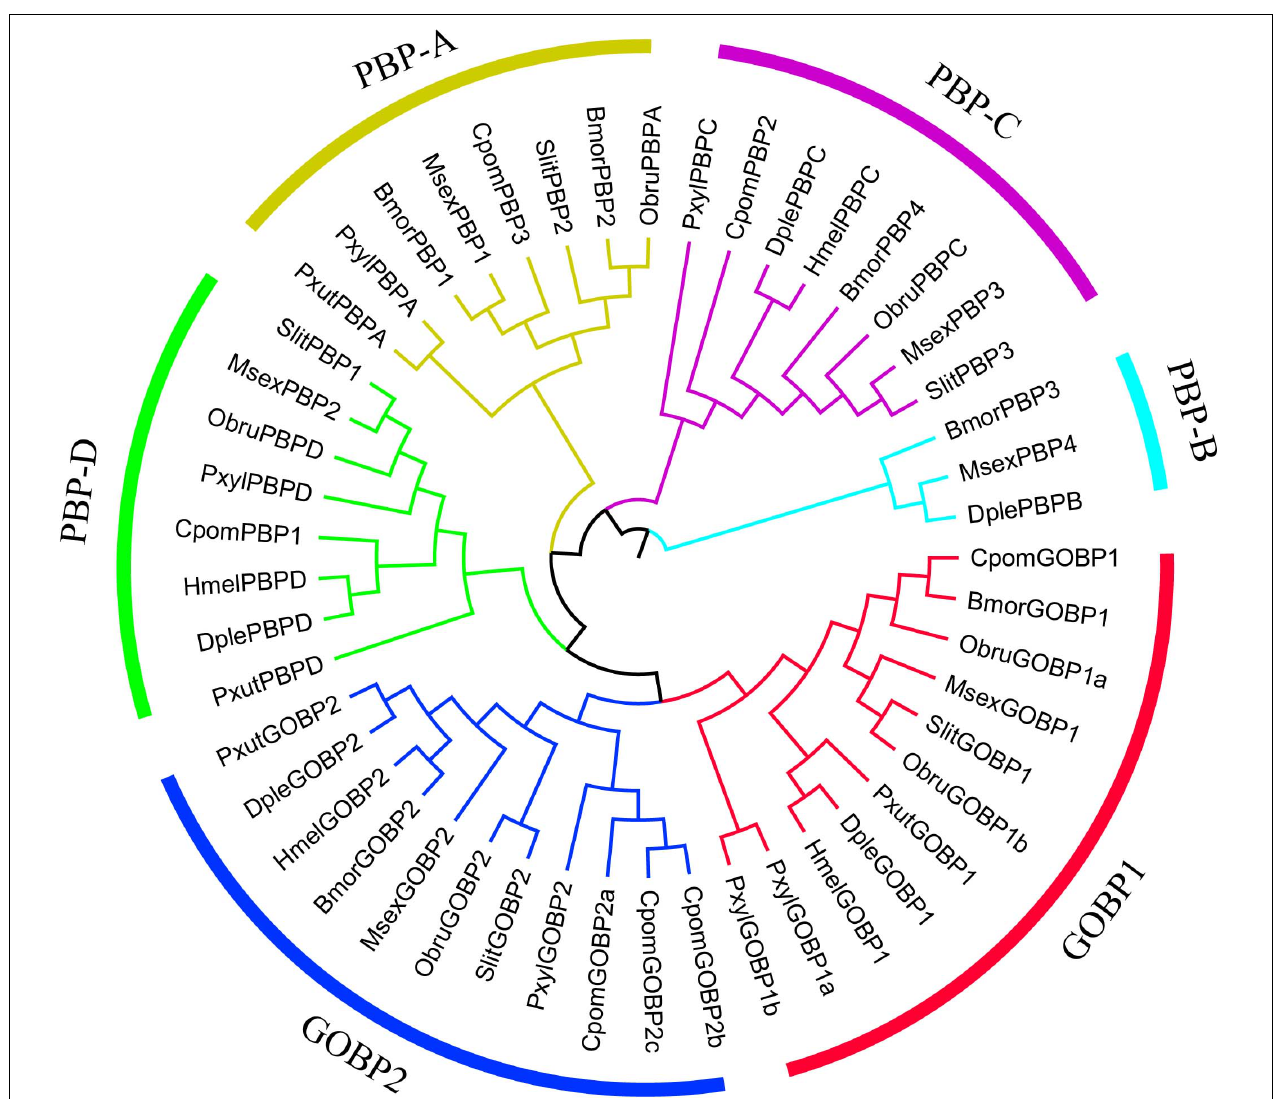
FIGURE 5 | Phylogenetic relationships of GOBP and PBP genes in lepidopteran insects. The maximum likelihood tree was constructed based on the 49 GOBP and PBP genes from nine lepidopteran species. The amino acid sequences were aligned by MAFFT v7 with default parameters, and then the alignments were trimmed by trimAl with the parameter “-automated1.” (Bmor: Bombyx mori , Cpom: Cydia pomonella , Dple: Danaus plexippus , Hmel: Heliconius melpomene , Msex: Manduca sexta , Obru: Operophtera brumata , Pxut: Papilio xuthus , Pxyl: Plutella xylostella , Slit: Spodoptera litura ). MEGA v6 was used to construct a Neighbor-Joining tree with the Jones-Taylor-Thornton (JTT) model and 1,000 bootstrap replications. FigTree v1.4.3 (http://tree.bio.ed.ac.uk/software/figtree/) and Adobe Illustrator CC 2017 were used to visualize and annotate the phylogenetic